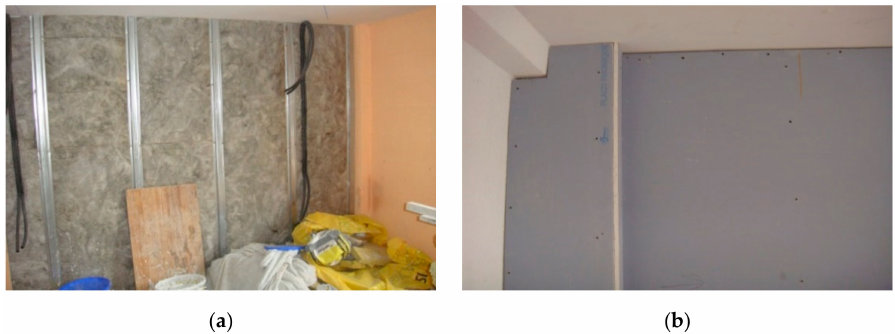
Figure 11. ( a ) Exterior façade of the dwelling under refurbishment; ( b ) Balcony façade detail.